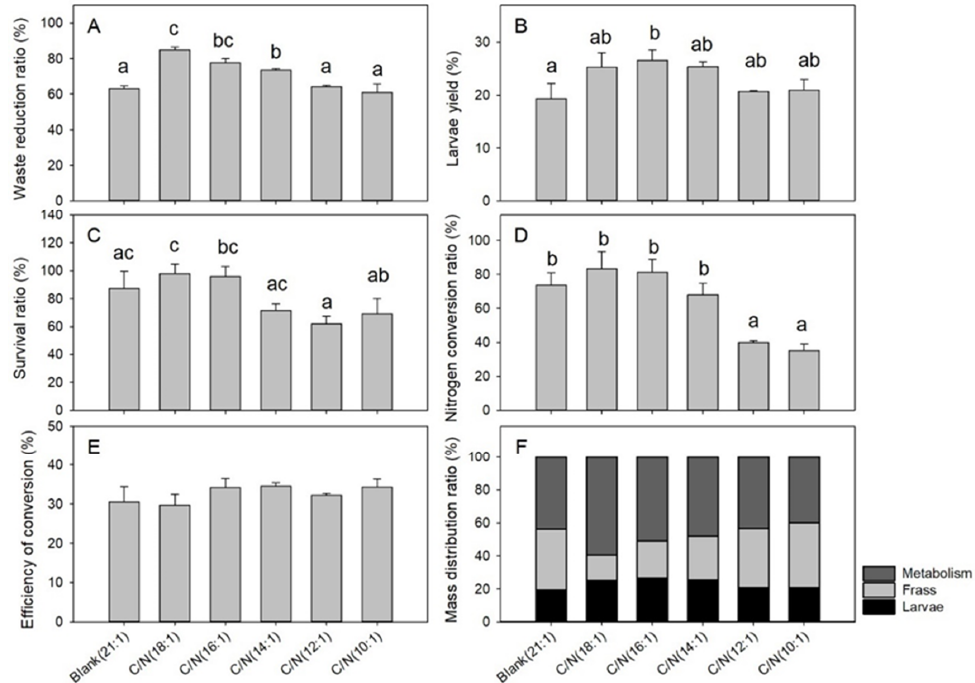
Figure 4. Bioconversion efficiencies following C/N adjustment in Trial 2. Error bars represent standard deviations ( n = 3). The ( A ) waste reduction ratio ( p < 0.001), ( B ) larvae yield ( p = 0.015), ( C ) survival ratio ( p = 0.004), and ( D ) nitrogen conversion ratio ( p < 0.001) are different among groups, and groups with different letters represent significant difference ( p < 0.05). The ( E ) efficiency of conversion and ( F ) mass distribution ratio show no significant differences among groups.